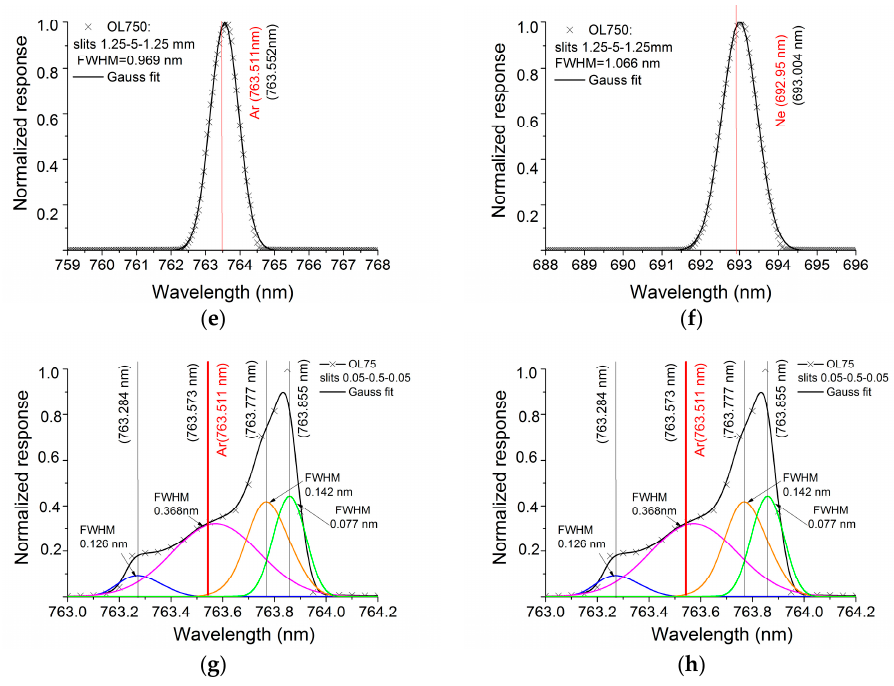
Figure 12. Ne ( left ) and Ar ( right ) lamps’ emission line measured with the double monochromator system OL 750D from Gooch & Housego and the corresponding standard absorption lines (red lines) [34] for slits’ combination at the monochromator entrance, middle and exit: ( a , b ) 5 mm, 5 mm and 5 mm; ( c , d ) 2.5 mm, 5 mm and 2.5 mm; ( e , f ) 1.25 mm, 5 mm and 1.25 mm; ( h , f ) 0.05 mm, 0.5 mm and 0.05 mm. The coloured lines represent the Gaussian fit applied to the multiple peaks under the envelope